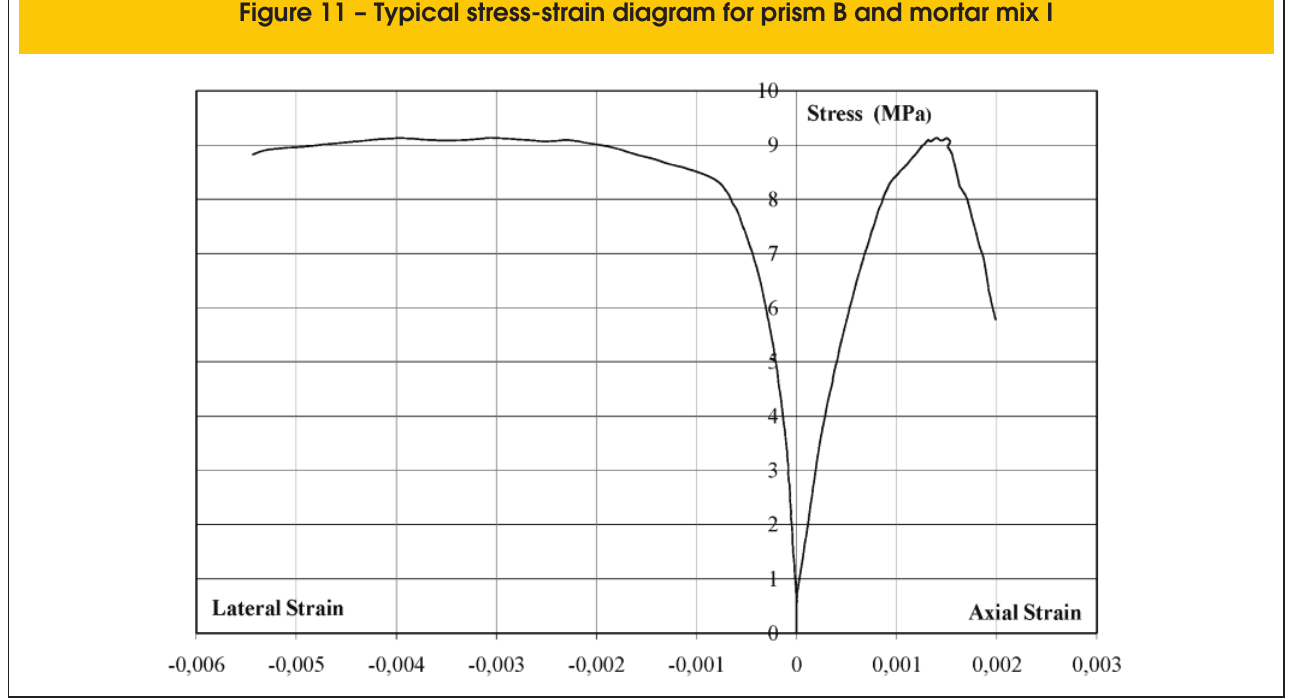
Figure 11 – Typical stress-strain diagram for prism B and mortar mix